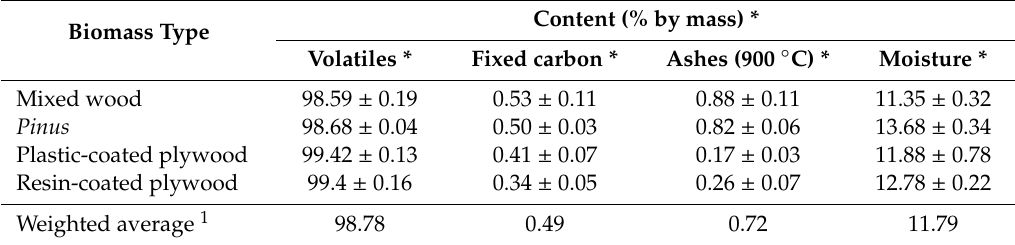
Table 4. Proximate analysis